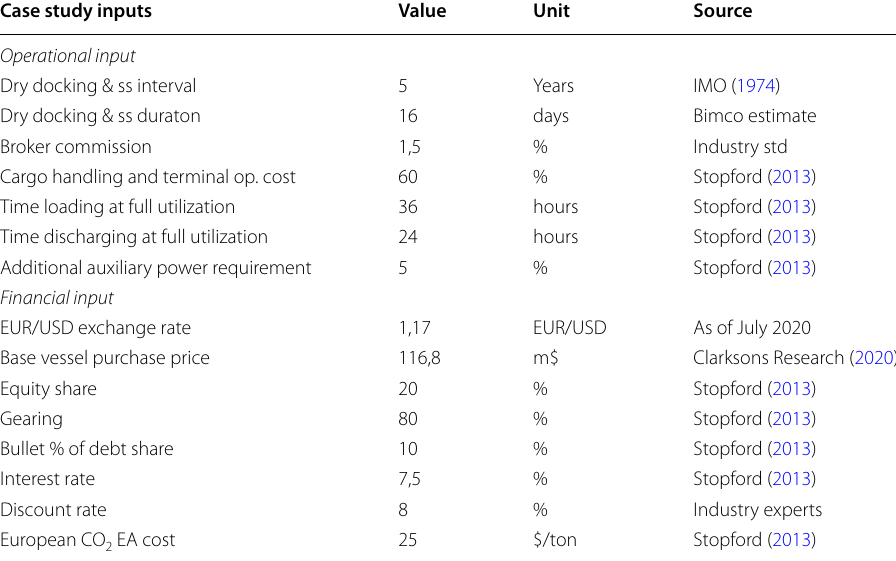
Table 8 Case study inputs